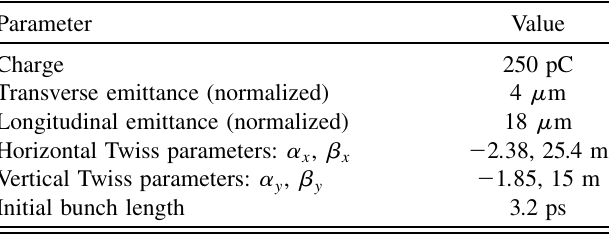
TABLE II. Beam parameters for the bunch length simulation. Parameter Value Charge 250 pC Transverse emittance (normalized) 4 (cid:5) m Longitudinal emittance